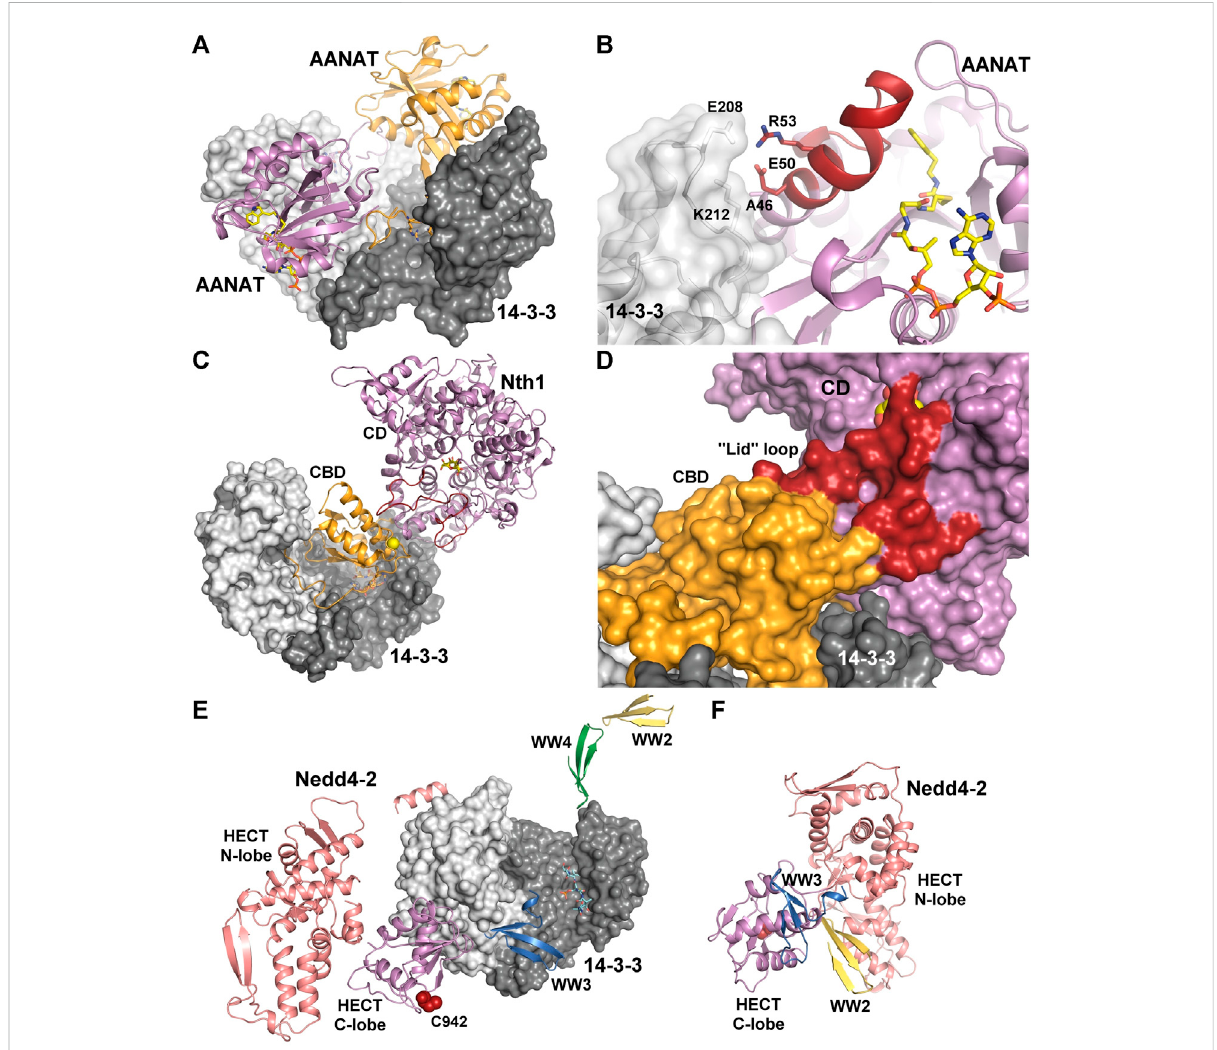
FIGURE 3 14-3-3 proteins as allostericmodulators of bound enzymes. (A) Crystal structure of the AANAT:14-3-3 ζ complex (PDB: 1IB1 (Obsil etal., 2001)). Thebisubstrateanaloginshownassticks. (B) DetailedviewofinteractionsbetweentheactivesiteofAANATand14-3-3 ζ .Thebisubstrateanalogand selected residues at the binding interface are shown as sticks. The region that undergoes a large structural rearrangement upon substrate binding is shown in dark red (Hickman et al., 1999a; Hickman et al., 1999b). (C) Crystal structure of the N th1:14-3-3 complex (PDB: 5N6N (Alblova et al., 2017)). The Ca 2+ -binding domain (CBD) is shown in orange, the catalytic domain (CD) is shown in violet. The fl exible part of the active site, which containsresiduesrequiredforcatalysisandisstabilizeduponformationofthecomplex(the “ lid ” loop)isshownindarkred.Thesucroseboundinthe active site and 14-3-3 binding motifs are shown as sticks. Ca 2+ ion is shown as yellow sphere. (D) Detailed view of the “ lid ” loop in surface representation.14-3-3bindingallows properorientation oftheregulatory CBDof N th1relativeto theCD,therebystabilizingthe “ lid ” loop. (E) SAXS- and chemical cross-linking-based model of the Nedd4-2:14-3-3 η complex (Pohl et al., 2021). The N- and C-lobes of the catalytic HECT domain of Nedd4-2 are shown in salmon and violet, respectively. WW2, WW3, and WW4 domains are indicated in yellow, blue and green, respectively. The catalytic Cys 942 is shown in dark red. The 14-3-3 binding motifs are shown as sticks. (F) SAXS- and chemical cross-linking-based model of apo Nedd4-2. All colors are the same as in panel (E) . The fi gure was prepared with PyMOL